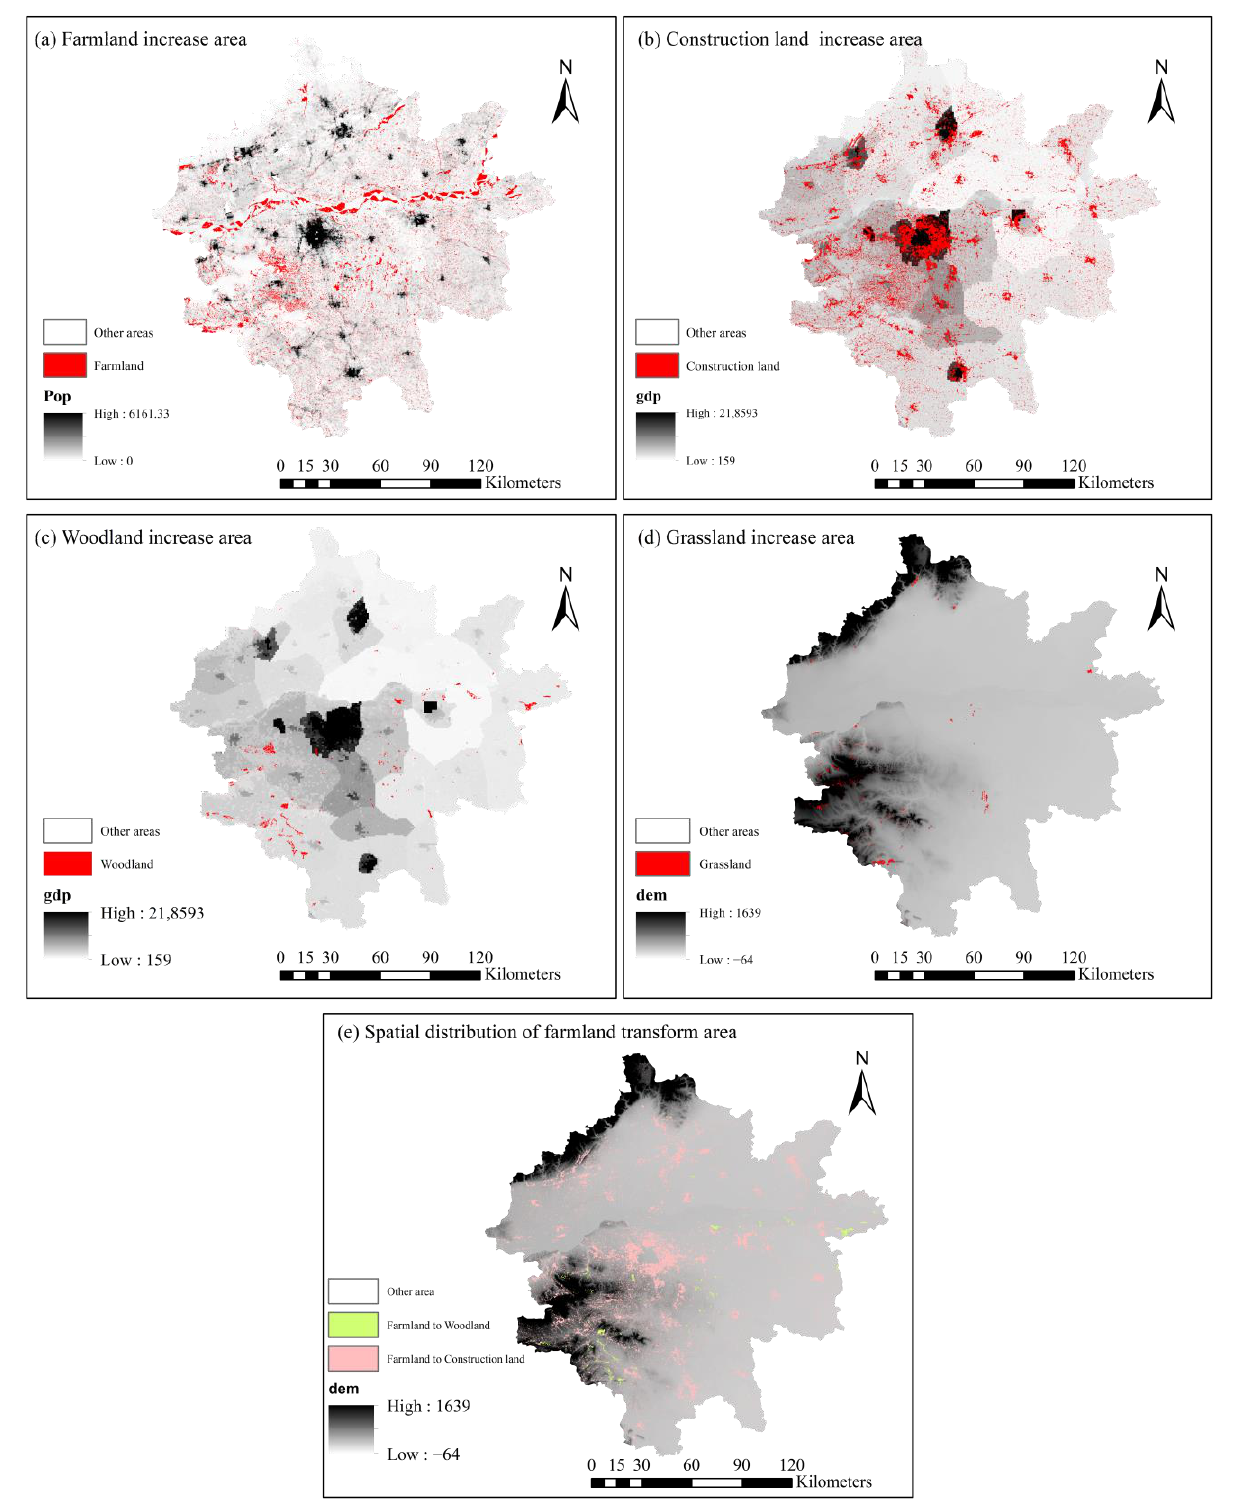
Figure 10. Land use-related factors of ( a ) farmland, ( b ) construction land, ( c ) woodland, ( d ) grassland, and ( e ) the spatial distribution of farmland transform area.